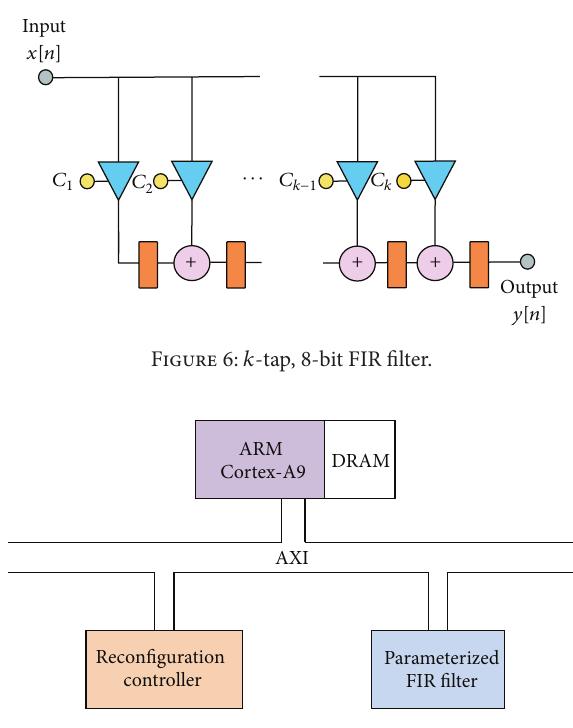
Figure 7: A self-reconfigurable platform for DCS